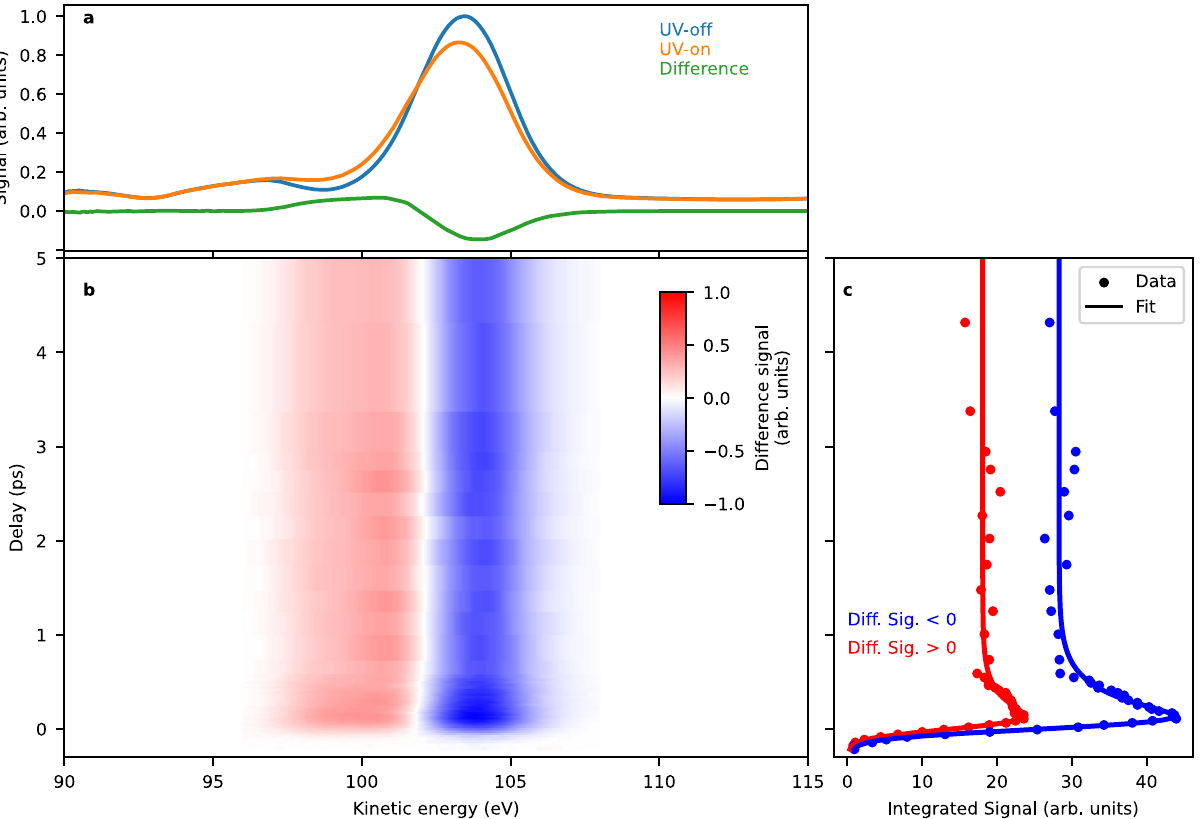
Fig. 2 Experimental time-resolved XPS spectra of 2-thiouracil. a UV-on (orange) and UV-off (blue) photoelectron spectra as well as the difference spectrum (green) between UV-on and UV-off at a delay of 200 fs. b False-colour plot of time-dependent difference XPS with red indicating UV-induced increase of the photoelectron spectrum and blue a UV-induced decrease. c Integrated signal of the positive (red) and negative (blue) parts of the difference spectra (dots) and fi t to the data (solid line). Source data are provided as Source Data fi